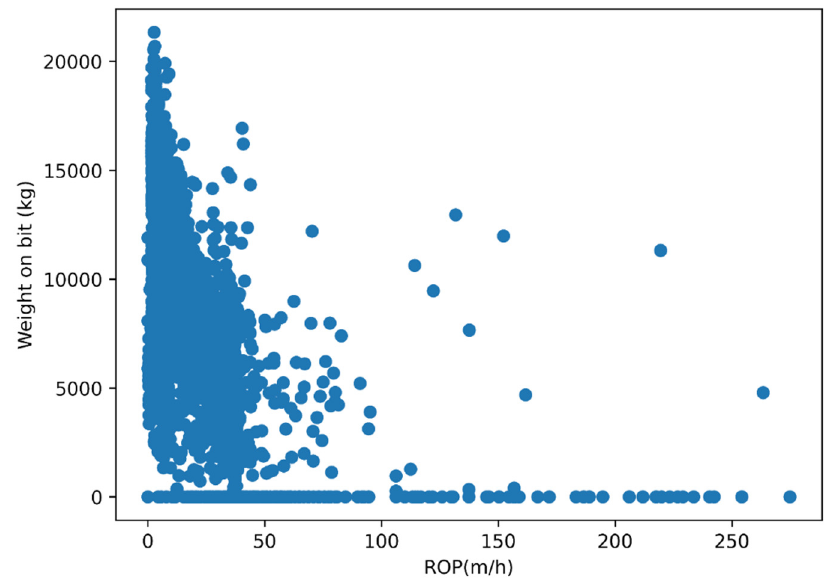
Figure 14. Weight on bit vs ROP scatter plot .